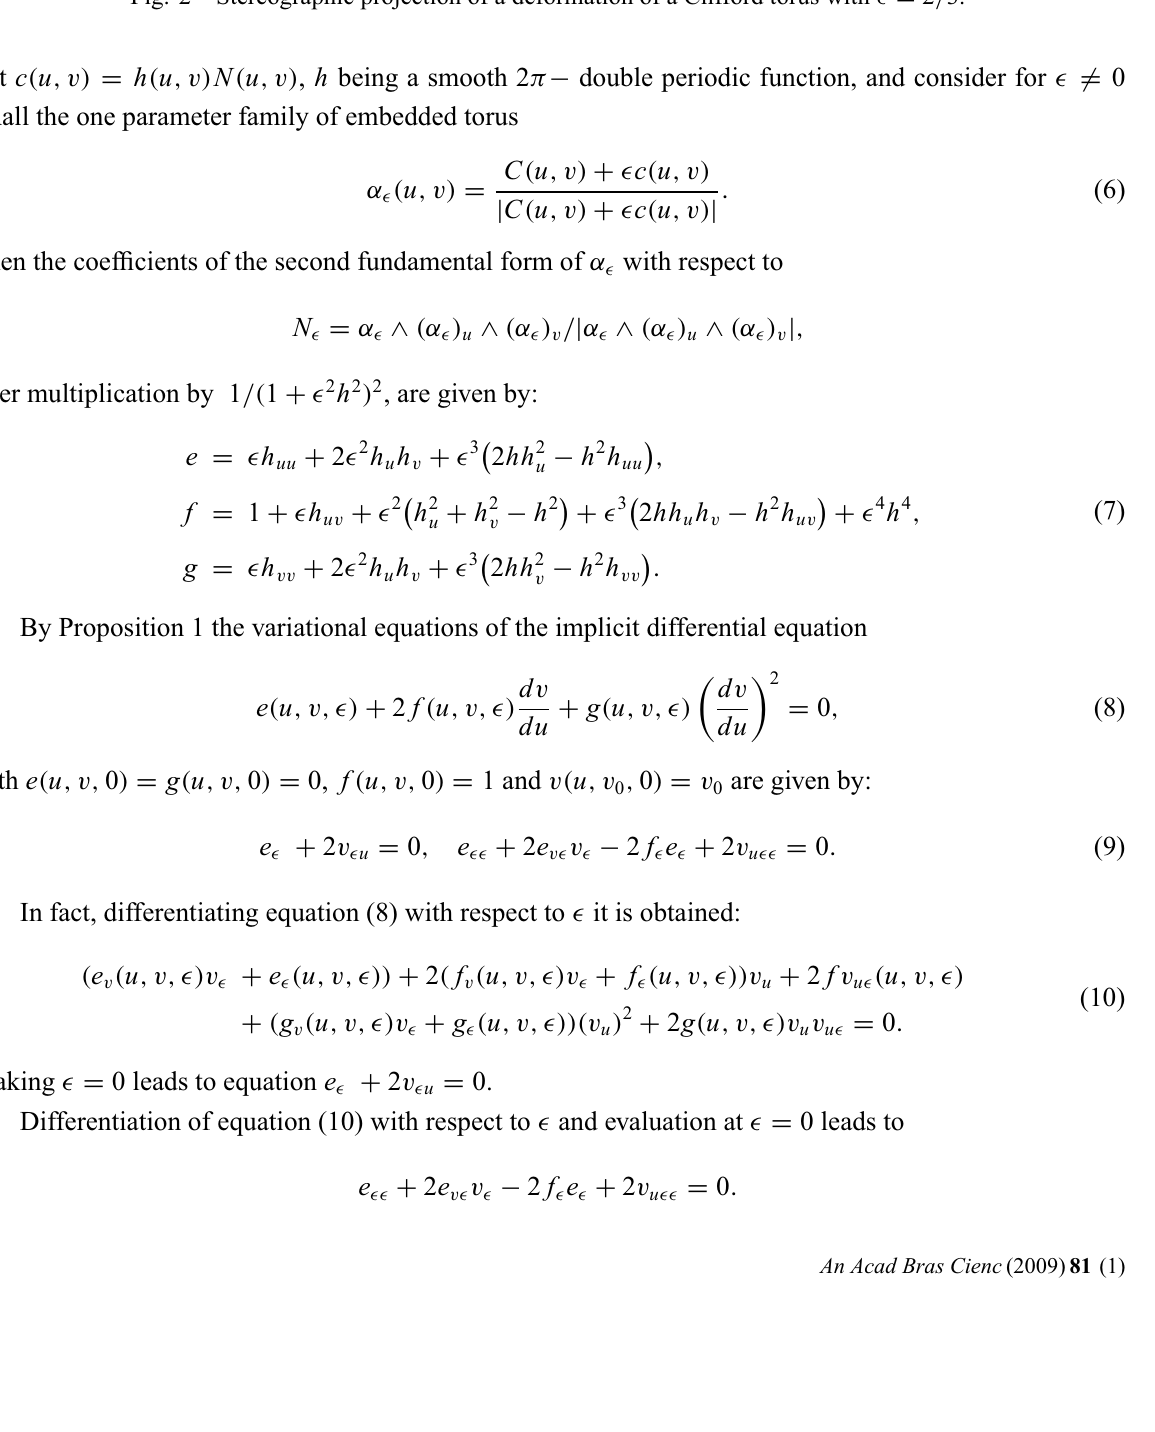
Fig. 2 – Stereographic projection of a deformation of a Clifford torus with